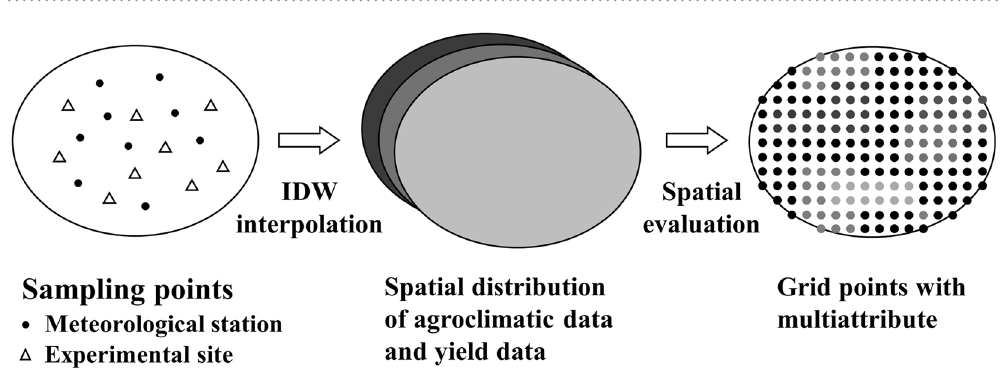
Figure 7. Construction process for the spatial vector database. The color of the circle represent the value of the